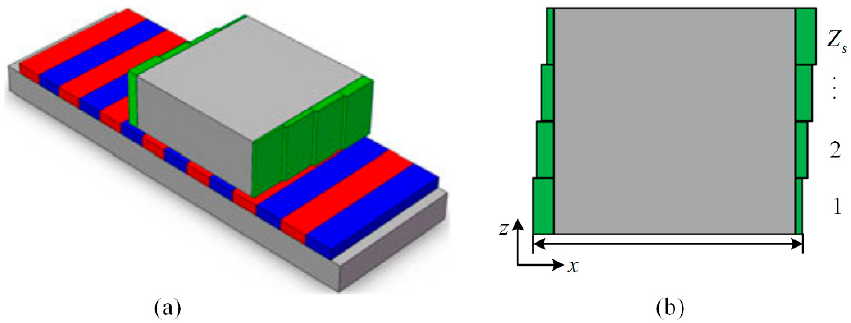
Figure 1. Installation of auxiliary structure. ( a ) Three-dimensional view; ( b ) two-dimensional view. Reprinted with permission from ref. [41]. Copyright 2018 IEEE.